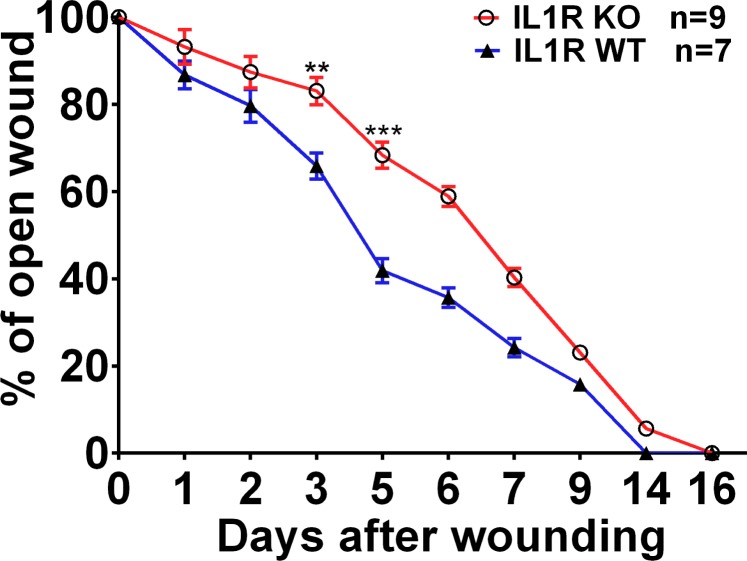
Wound closure rate in the skin of WT and IL1R KO mice.5 mm excisional wounds were made on 8-week-old IL1R KO and WT control males. Wound closure was determined as the percentage size reduction compared to day 0.